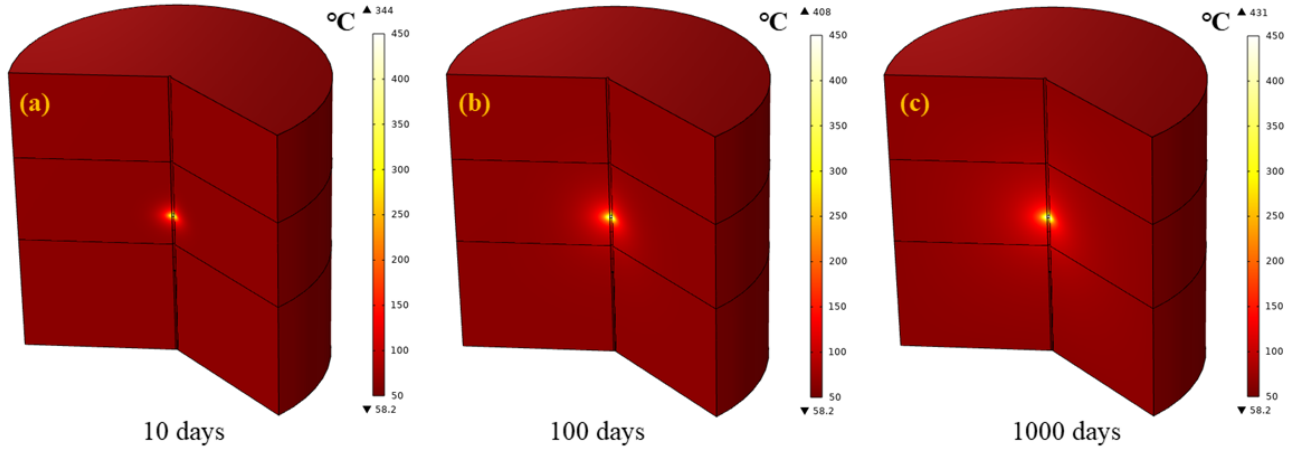
Figure 5. Reservoir temperature distribution of oil shale formation under microwave irradiation at